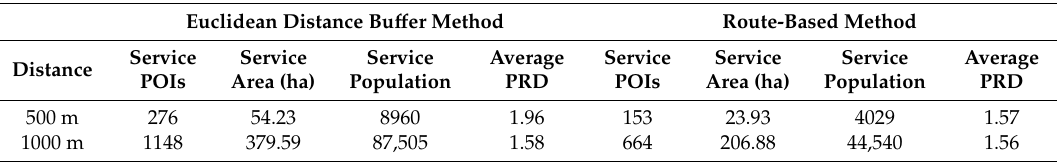
Table 2. Di ff erent methods for determining the pedestrian shed of Xuanwu Lake Park, in terms of service points of interest (POIs), area, population, and pedestrian route directness